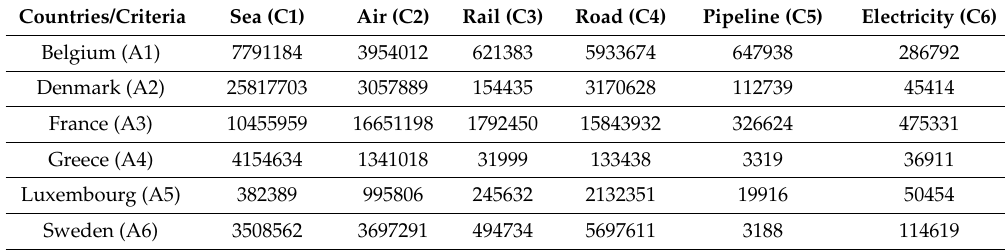
Table A8. Selected Data of Transport Import for the EU by 2013 (US Dollar, Thousand).